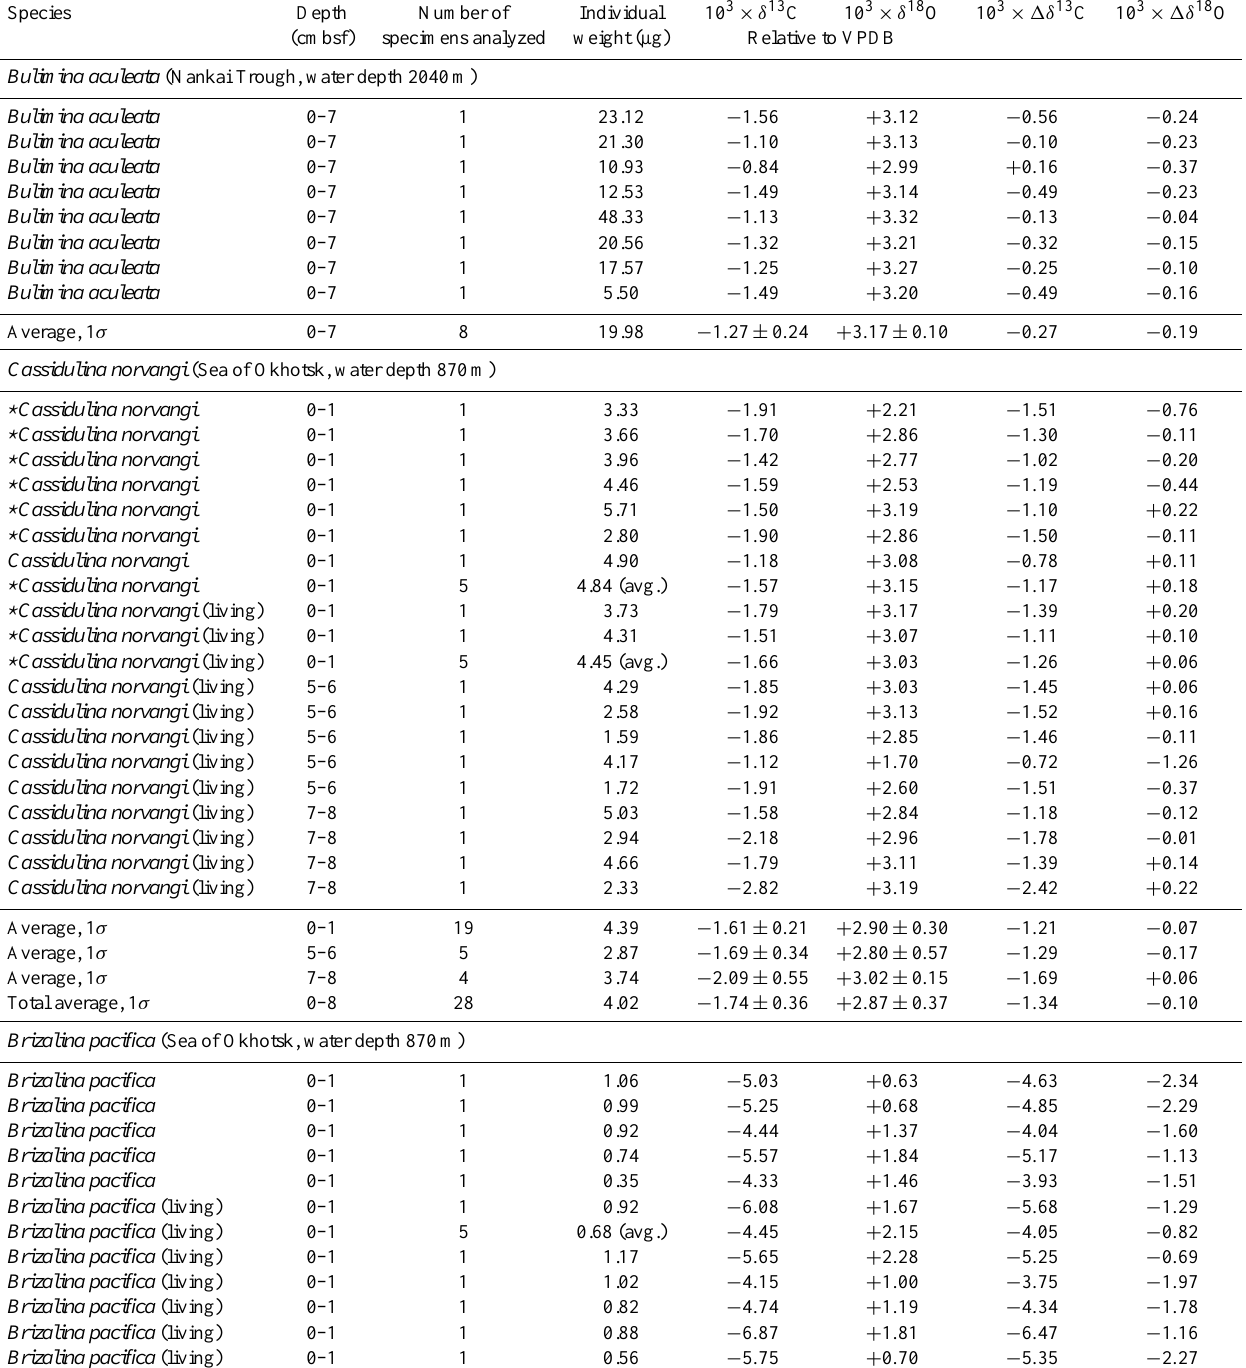
Table 2. δ 13 C and δ 18 O values of individual foraminiferal shells collected from the surface sediment at study sites, as well as the averages of multiple specimens analyzed together. 1δ 13 C, isotopic difference between the δ 13 C of analyzed foraminiferal shell and the δ 13 C of DIC ( δ 13 C DIC ) in bottom water; 1δ 18 O, isotopic difference between the δ 18 O of analyzed foraminifera and the δ 18 O of calcite in equilibrium with bottom water ( δ 18 O e.c. ) . Results of δ 13 C and δ 18 O analysis for Cassidulina norvangi reported in a previous study (Ishimura et al., 2004) are denoted by an asterisk. Living: Rose Bengal-stained. Cmbsf: cm below the sea floor. Species Depth Number